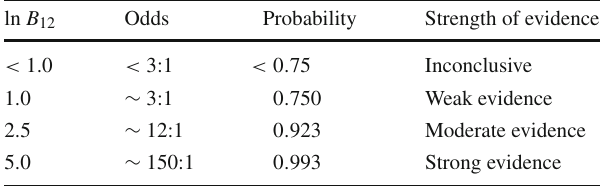
Table 1 Jeffreys’ scale for model selection with the logarithm of the Bayes’ factor. ln B 12 Odds